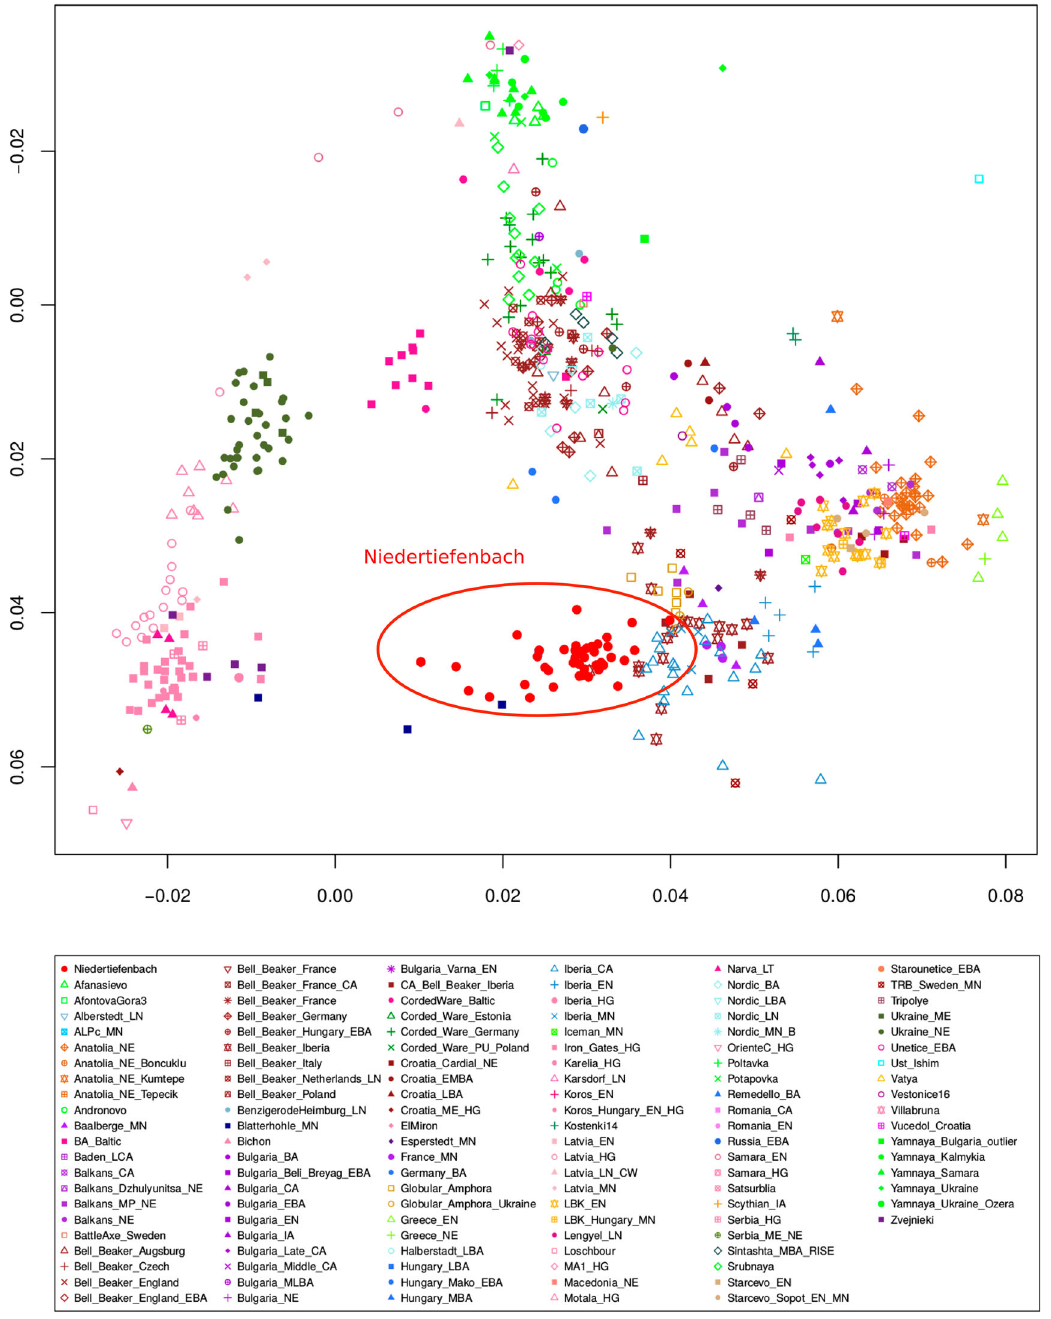
Fig. 2 PCA of individuals from 123 ancient populations including Niedertiefenbach. PCA of individuals were projected onto the fi rst two principal components calculated from 59 present-day West-Eurasian populations (not shown for clarity). Niedertiefenbach individuals are depicted as red